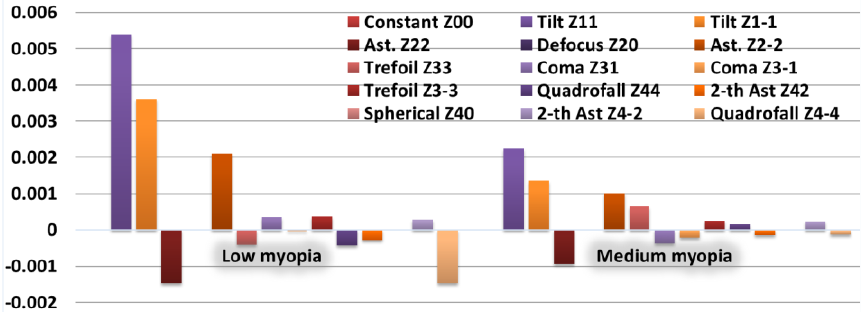
Figure 2. Values of the coefficients that must be subtracted from the anterior surface of the cornea for diagnoses of low and medium myopia (presentation by diagnoses).